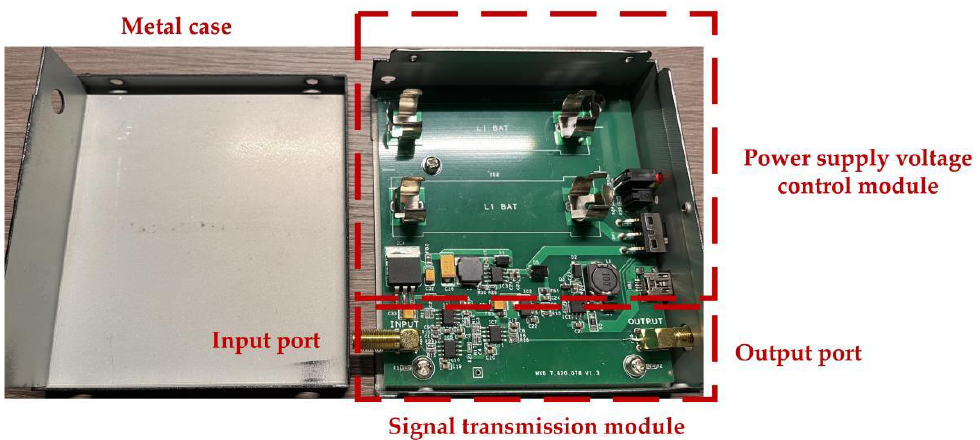
Figure 8. Complete manufactured prototype of new signal conditioning sensor.